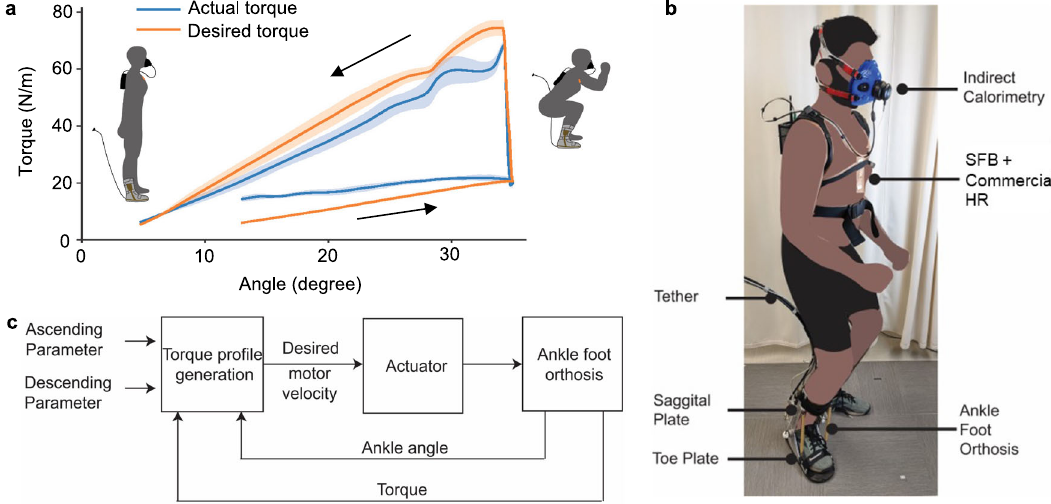
Fig. 3 Overview of a robotic AFO system and experimental setup. a Comparison between the actual torque (blue) and desired torque (orange) according to ankle angle. The angle-torque relationship compares the torque trajectory commanded to the low-level controller and the corresponding torque observed at the exosuit. b Illustration of the experiment setup, where the subject wears the AFO exosuit on the right foot, the SFB measuring ECG, and the mask-based calorimetry device on the face. c Detailed system architecture for the mid-level and low-level